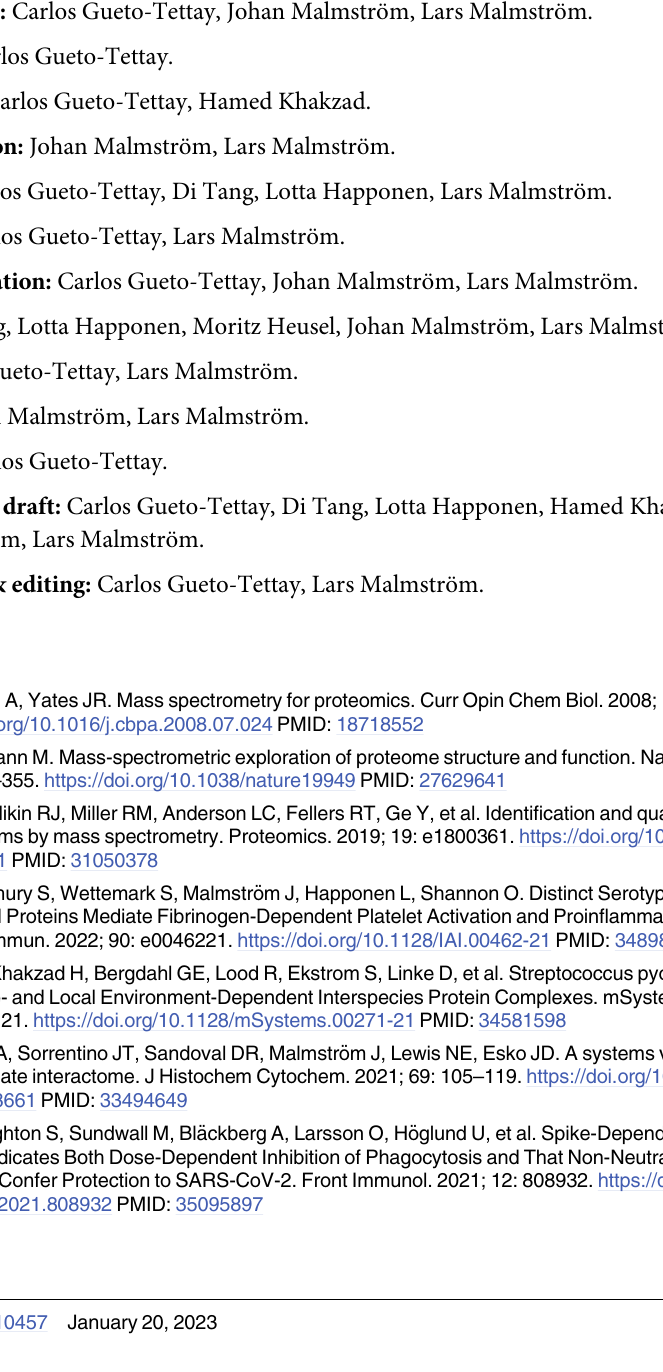
S3 Text. Positional mAb data for the Giga+ MEM model de novo results. A. Positional fre- quency values across all residues composing the ten mAb polypeptides proteins; B. Positional frequency information for the heavy and light subunits; C. Confident positional score (CS) val- ues for the variable and constant domains of the heavy and light chains. For the color scheme, we used dark and light brown colors for the heavy and light chains, respectively. S1 Table. Sheets: ModelAttributes. GlobalRecall. LocalRecall. AntibodyCoverage.